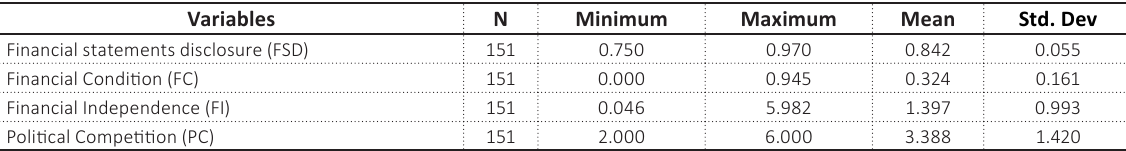
Table 3. Summary of descriptive